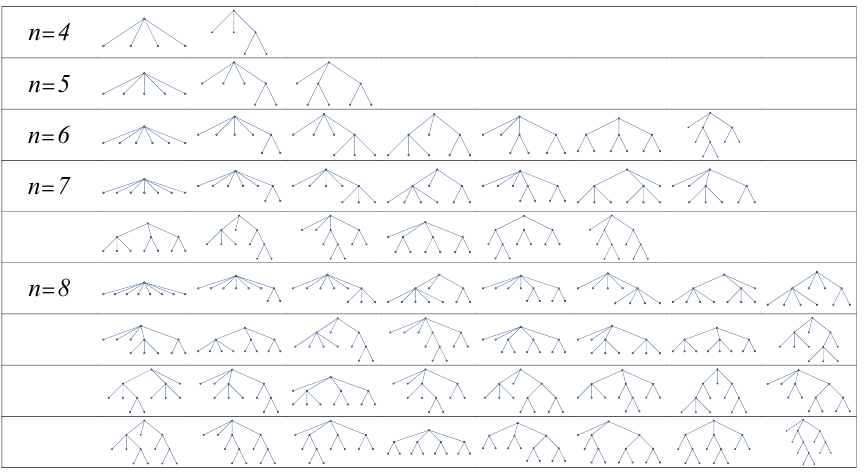
Figure 6 . The tree level topologies up to 8 external particles obtaind by the qgraf-3.5.0 [51]